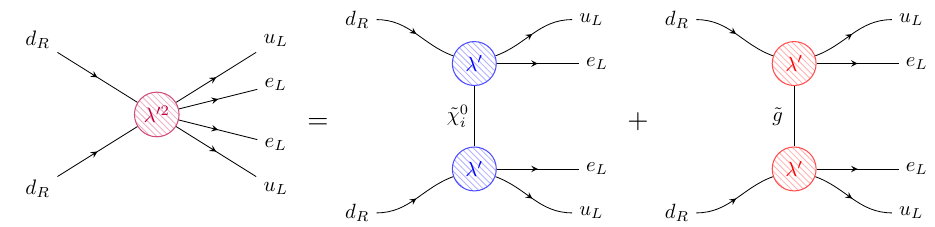
Figure 1 . Short-range 0 νββ decay mechanism induced by the RPV coupling λ 0 . The process can 111 proceed via the exchange of a neutralino ˜ χ 0 or gluino ˜ g . The effective interactions indicated by blue i and red blobs are induced by the exchange of a selectron, up or down squark (shown in figure 2). If the neutralino is lighter than the relevant momentum exchange, this mechanism becomes long-range.